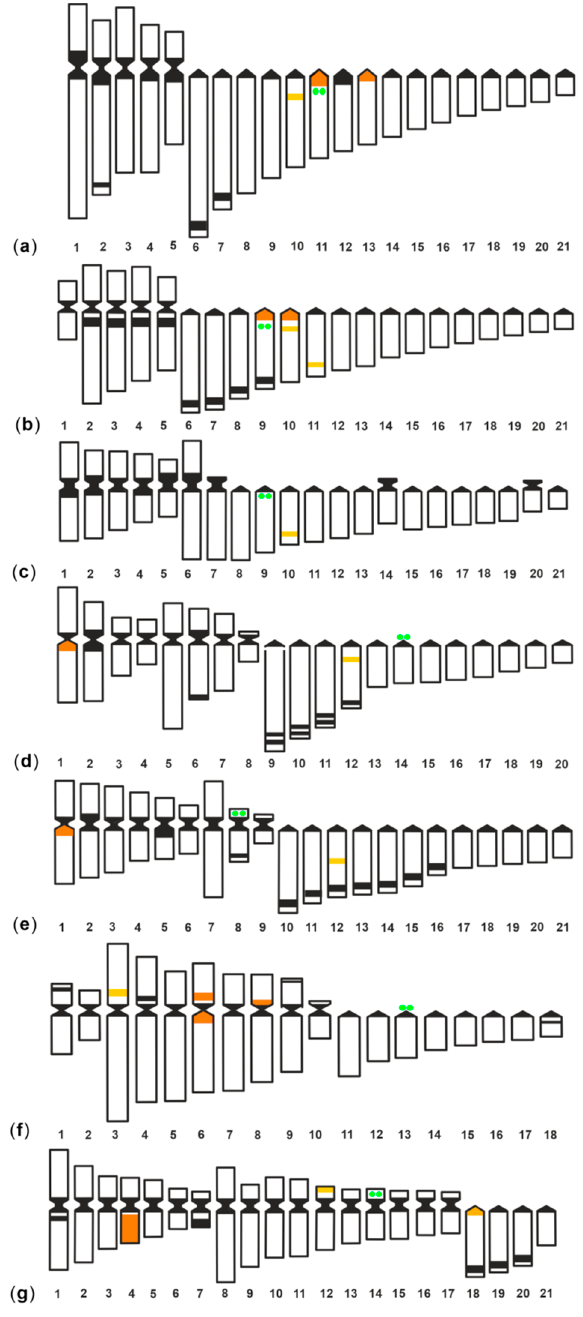
Figure 3. Compared idiograms of ( a ) Gymnothorax undulatus ; ( b ) G. fimbriatus ; ( c ) G. unicolor ; ( d ) G. javanicus ; ( e ) Muraena helena ; ( f ) G . flavimarginatus ; and ( g ) G. tile showing the C banding pattern (black regions), the 45S rDNA sites (green coloured) and the 5S rDNA sites (yellow coloured). The regions where the 5S rDNA clusters where located in heterochromatic regions are orange coloured. Chromosomes are ordered and numbered first into three groups (metacentric, submetacentric, and subtelocentric/acrocentric) and then by decreasing size within each of the three groups.